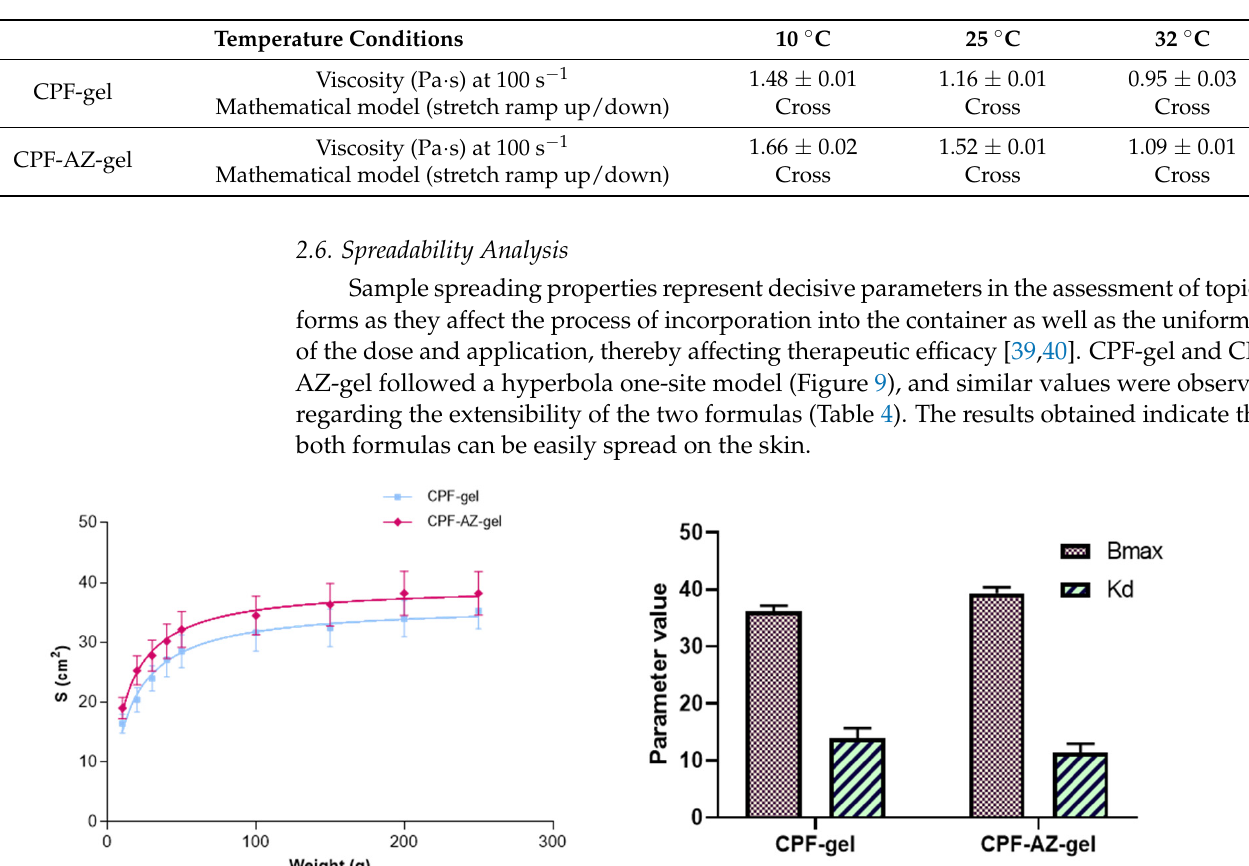
Table 3. Viscosity and mathematical fi tt ing of caspofungin formulations at 10, 25 and 32 °C.